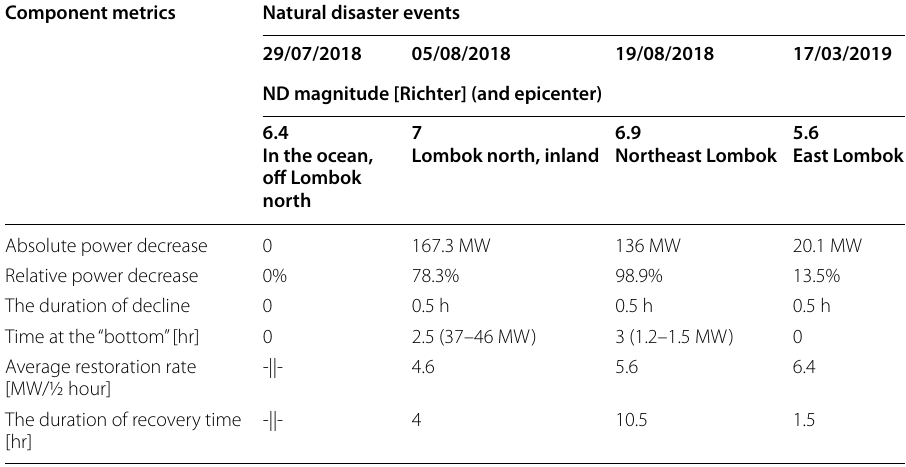
Table 1 Result overview for climate resilience components during natural disaster strikes Component